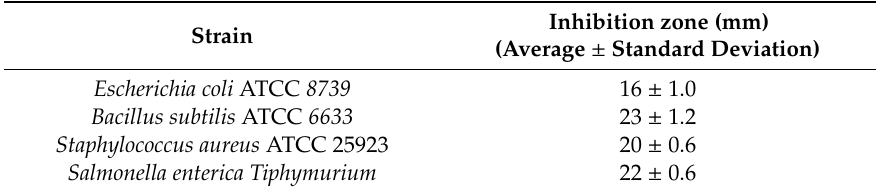
Table 2. Antibacterial activity of the essential oil of P. dioica leaves.